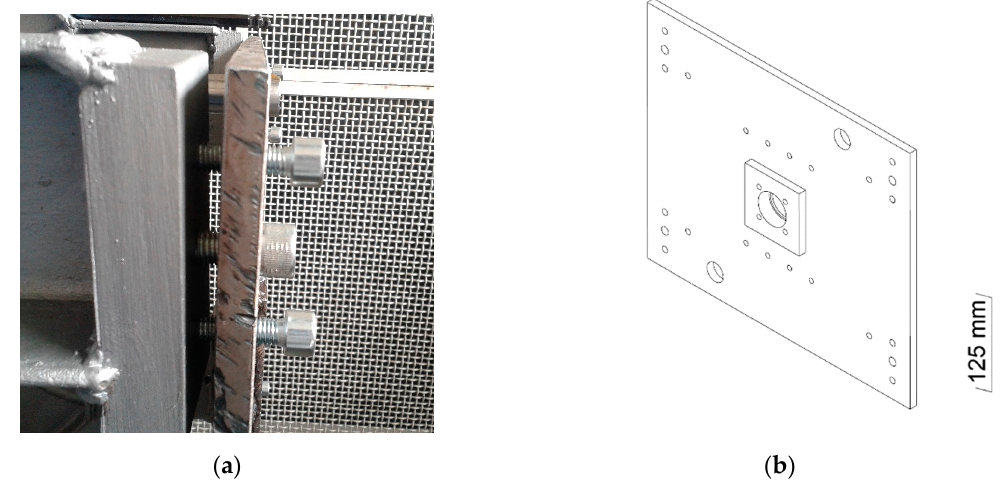
Figure 5. Final lateral plate: ( a ) Position adjusting system (no scale); ( b ) Isometric view.